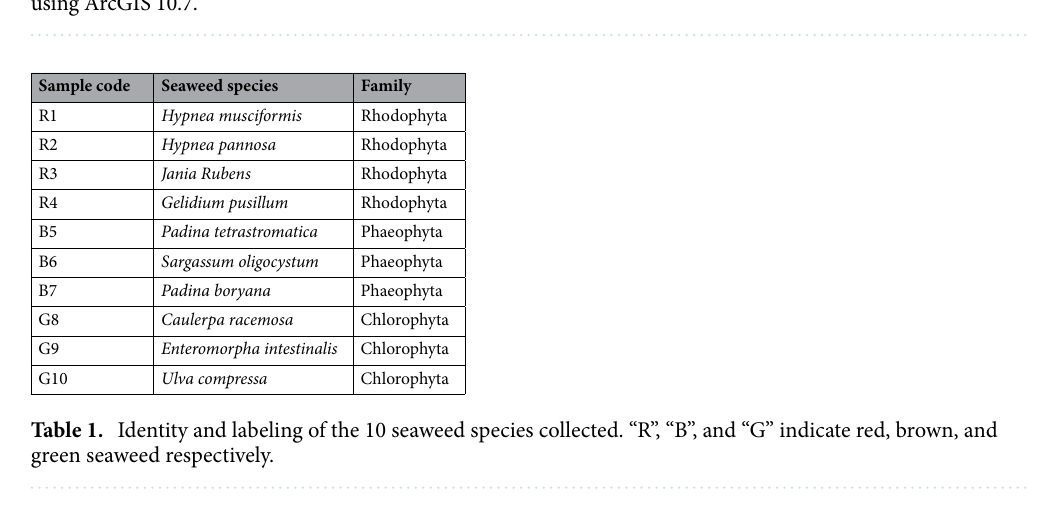
Figure 1. Map of the sampling locations in Cox’s Bazar and Saint Martin’s Island. The map was constructed using ArcGIS 10.7.